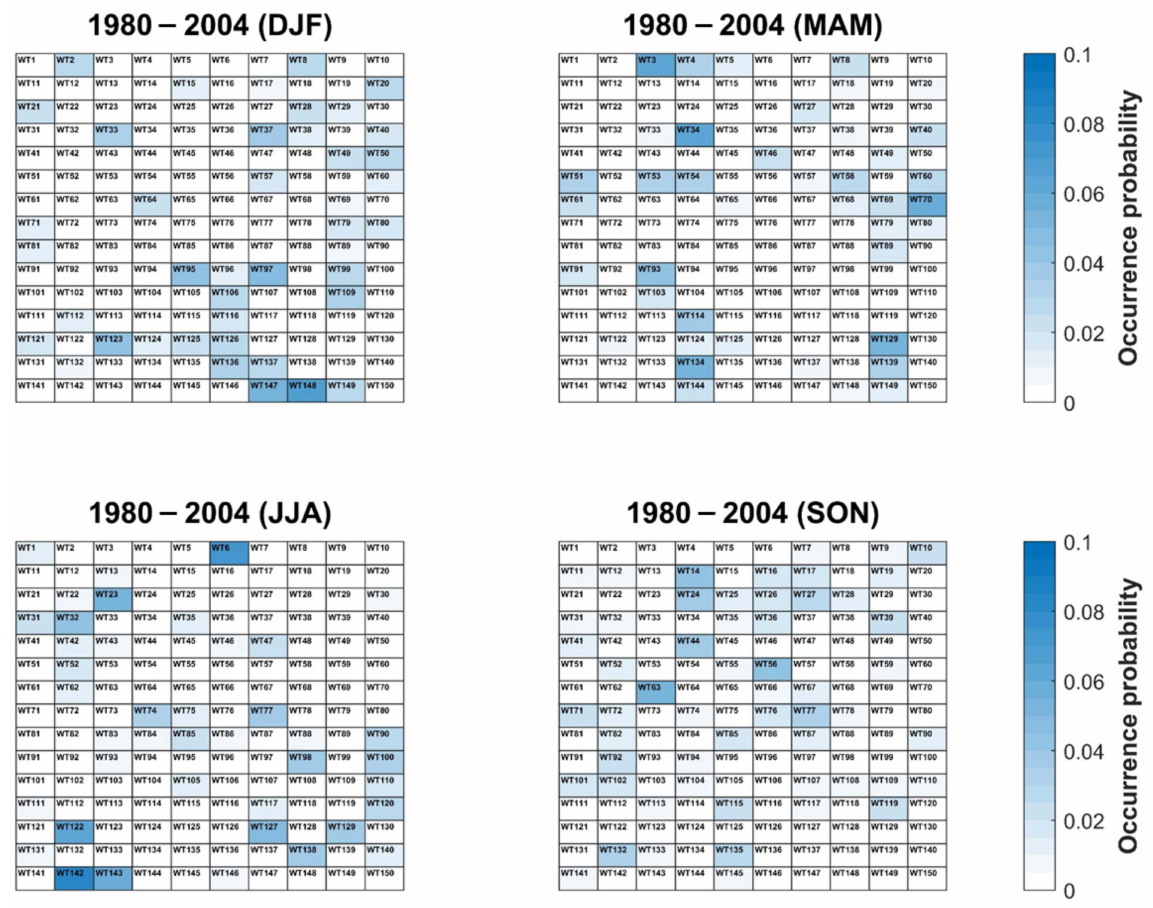
Figure 9. Seasonal occurrence probability of 150 weather types for the reference period from 1980 to